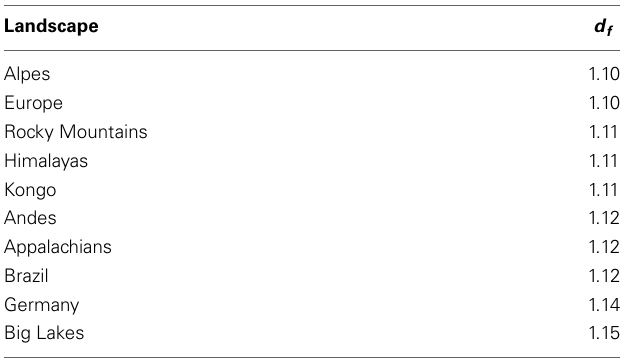
Table 1 | Fractal dimension of watersheds for natural landscapes obtained from satellite imagery [30] in [34].